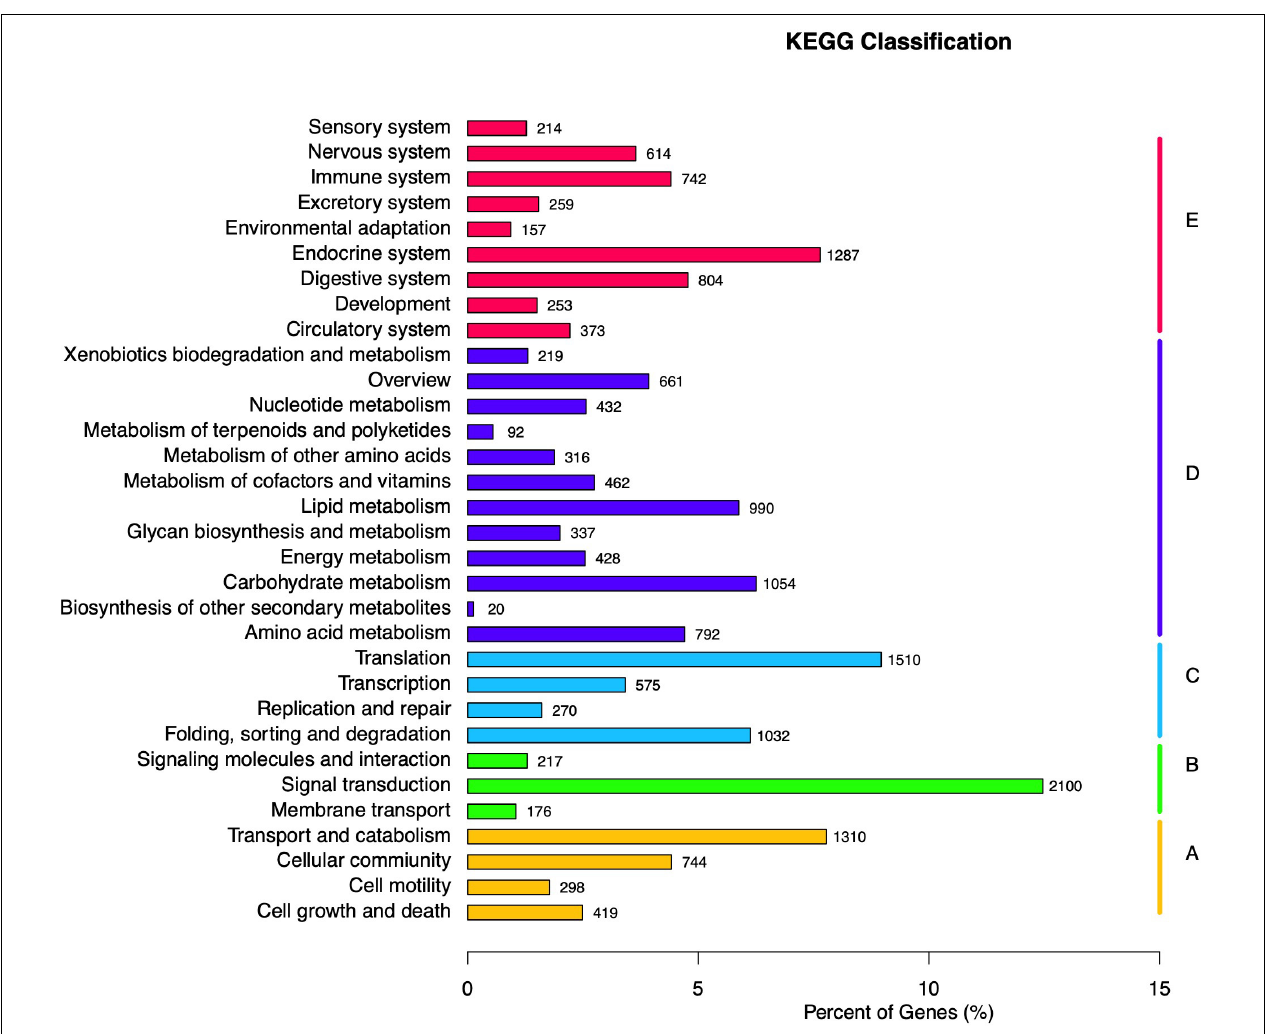
FIGURE 3 | Kyoto Encyclopedia of Genes and Genomes (KEGG) classification of Apriona germari unigene. The x -axis indicates the percentage of annotated genes, and the y-axis indicates the KEGG categories. The capital letters against the colored bars indicate five main categories: (A) cellular processes, (B) environmental information processing, (C) genetic information processing, (D) metabolism, and (E) organism